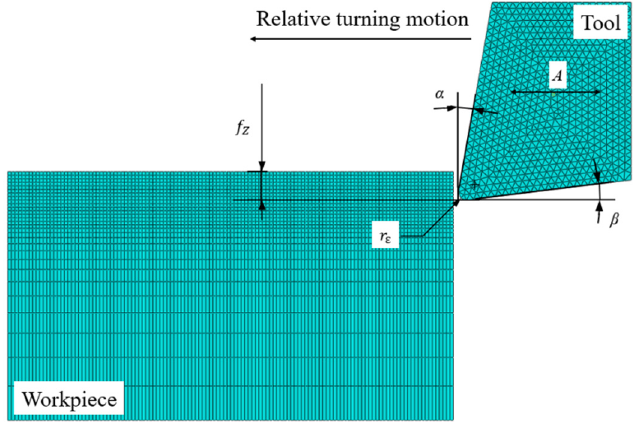
Figure 7. Parameters and meshing of BMG turning simulation.